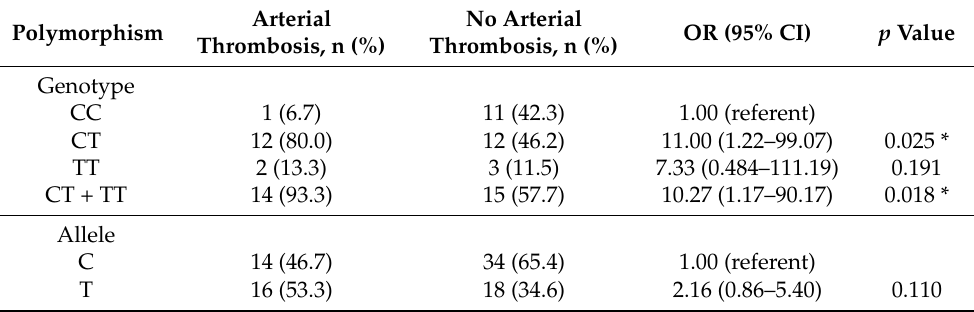
Table 5. Arterial thrombosis and MTHFR C677T polymorphism in APS